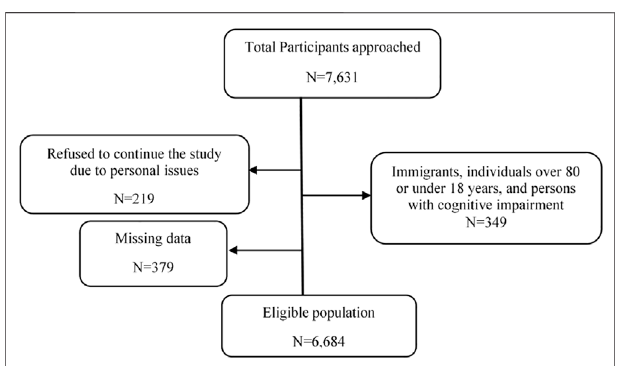
FIGURE 2 | Fears of individuals regarding MDR